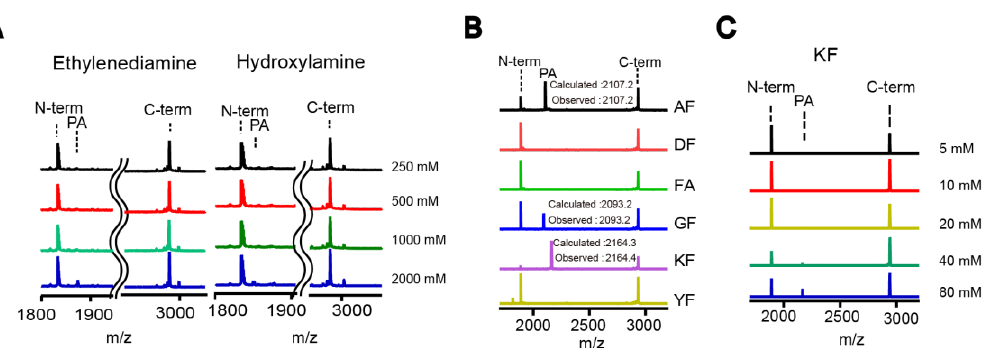
Figure 2. The DegP protease can mediate transpeptidation with proper nucleophiles. ( A ) A model substrate (18–58; 20 µ M) was cleaved by DegP (2 µ M) in the presence of ethylenediamine or hydroxylamine (0.25–2 M), and the reaction products were analyzed by MALDI-TOF-MS (N-term, N-terminal fragment; C-term, C-terminal fragment; PA, probe-addition product). Representative spectra are shown (n = 3). ( B , C ) The MALDI analysis of the products of the same cleavage reactions as in ( A ), but in the presence of various dipeptides (200 mM; ( B ); n = 1) or various concentrations of the KF dipeptide (5–80 mM; ( C )). Representative spectra are shown in ( C ) (n = 3).